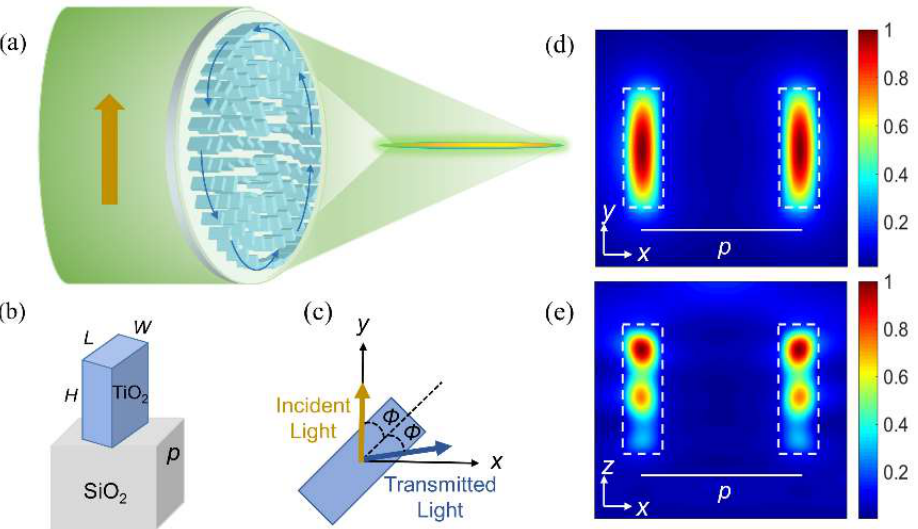
Figure 2. ( a ) Schematic of the needle beam generator based on the PB metalens. The yellow and blue arrows show the polarization directions of the incident or transmitted light, respectively. ( b ) Schematic illustration of a nanobrick of TiO 2 sets on a substrate of SiO 2 . L and W represent the length and width of the nanobrick, respectively. ( c ) Each unit cell acts as a local half-wave plate. ( d , e ) The magnetic energy density of x–polarized light at the x–y cross − section above the TiO 2 interface 0.5 µ m and x–z cross − section, respectively. The white dotted line indicates the boundary of the nanobrick (parameters: L = 250 nm, W = 95 nm).